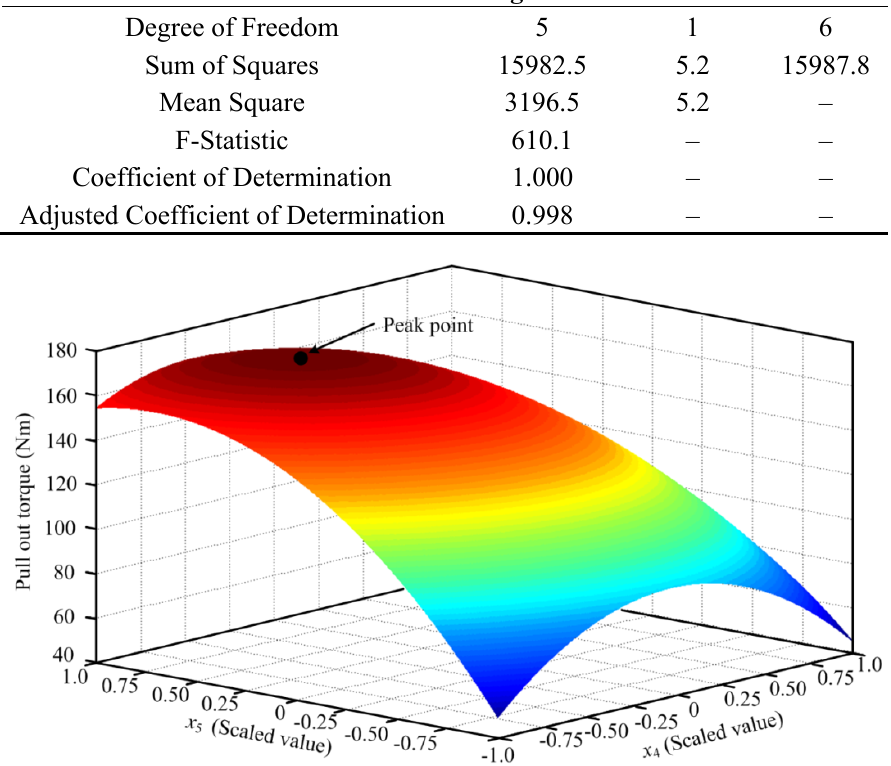
Figure 3. Responses of fitted model concerning ( x 4 , x 5 ).